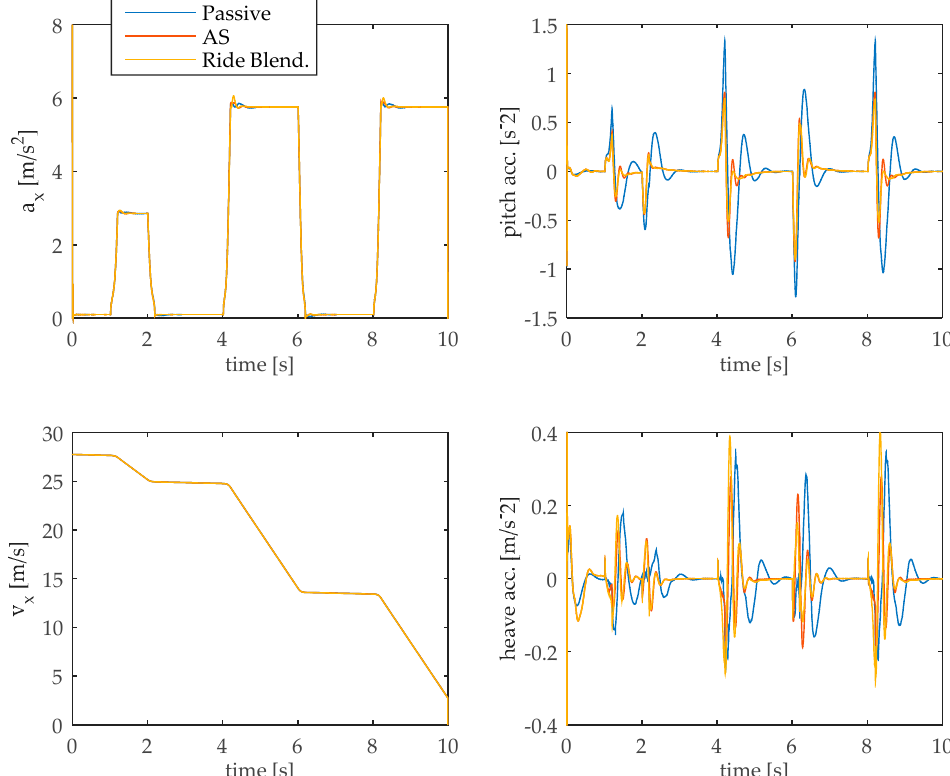
Figure 9. Simulation results for the straight line braking involving three consecutive brake pedal actuations.